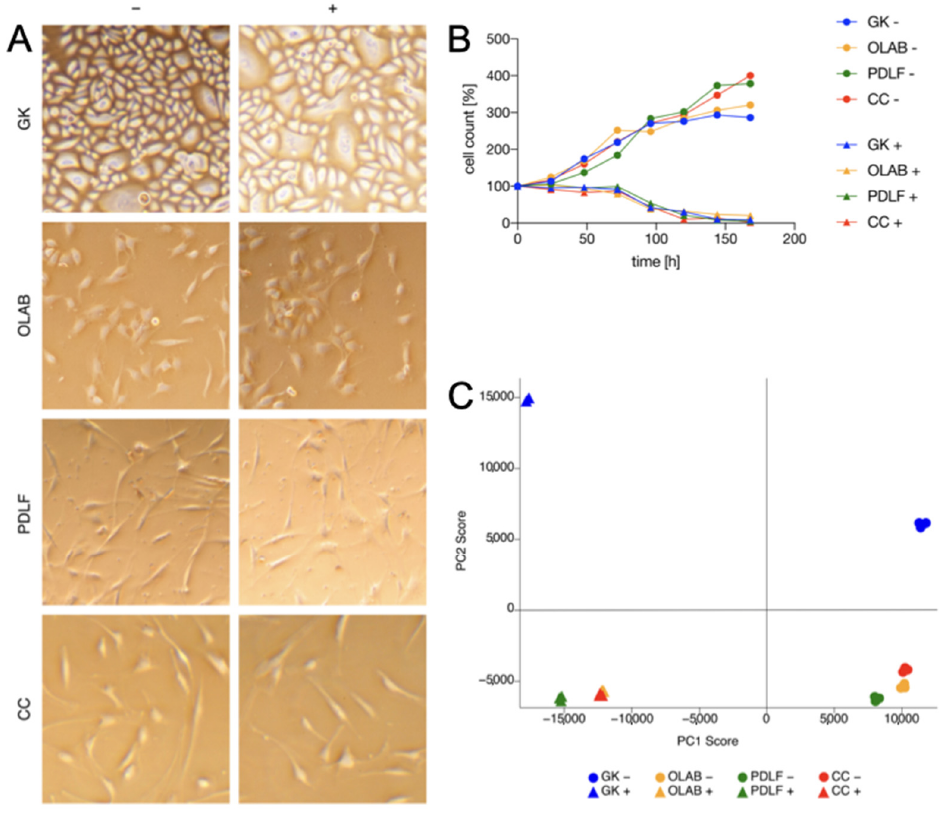
Figure 1. Cell culture and principal component analysis of the investigated oral cells. ( A ) Cytology. Ectodermal GK shows typical epithelial characteristics, such as a cobblestone morphology, high cell density, and direct cell-cell contacts. Mesodermal OLAB, PDLF, and CC exhibit a distinctive fibro- blast-like shape. ( B ) Proliferation and apoptosis over 1 week. Culture with bacteria leads to signs of apoptosis after 72 h, ( C ) principal component analysis. Axes reflect the diversity of the proteome. “+” indicates culture with bacteria; “ − ” indicates culture without bacteria.